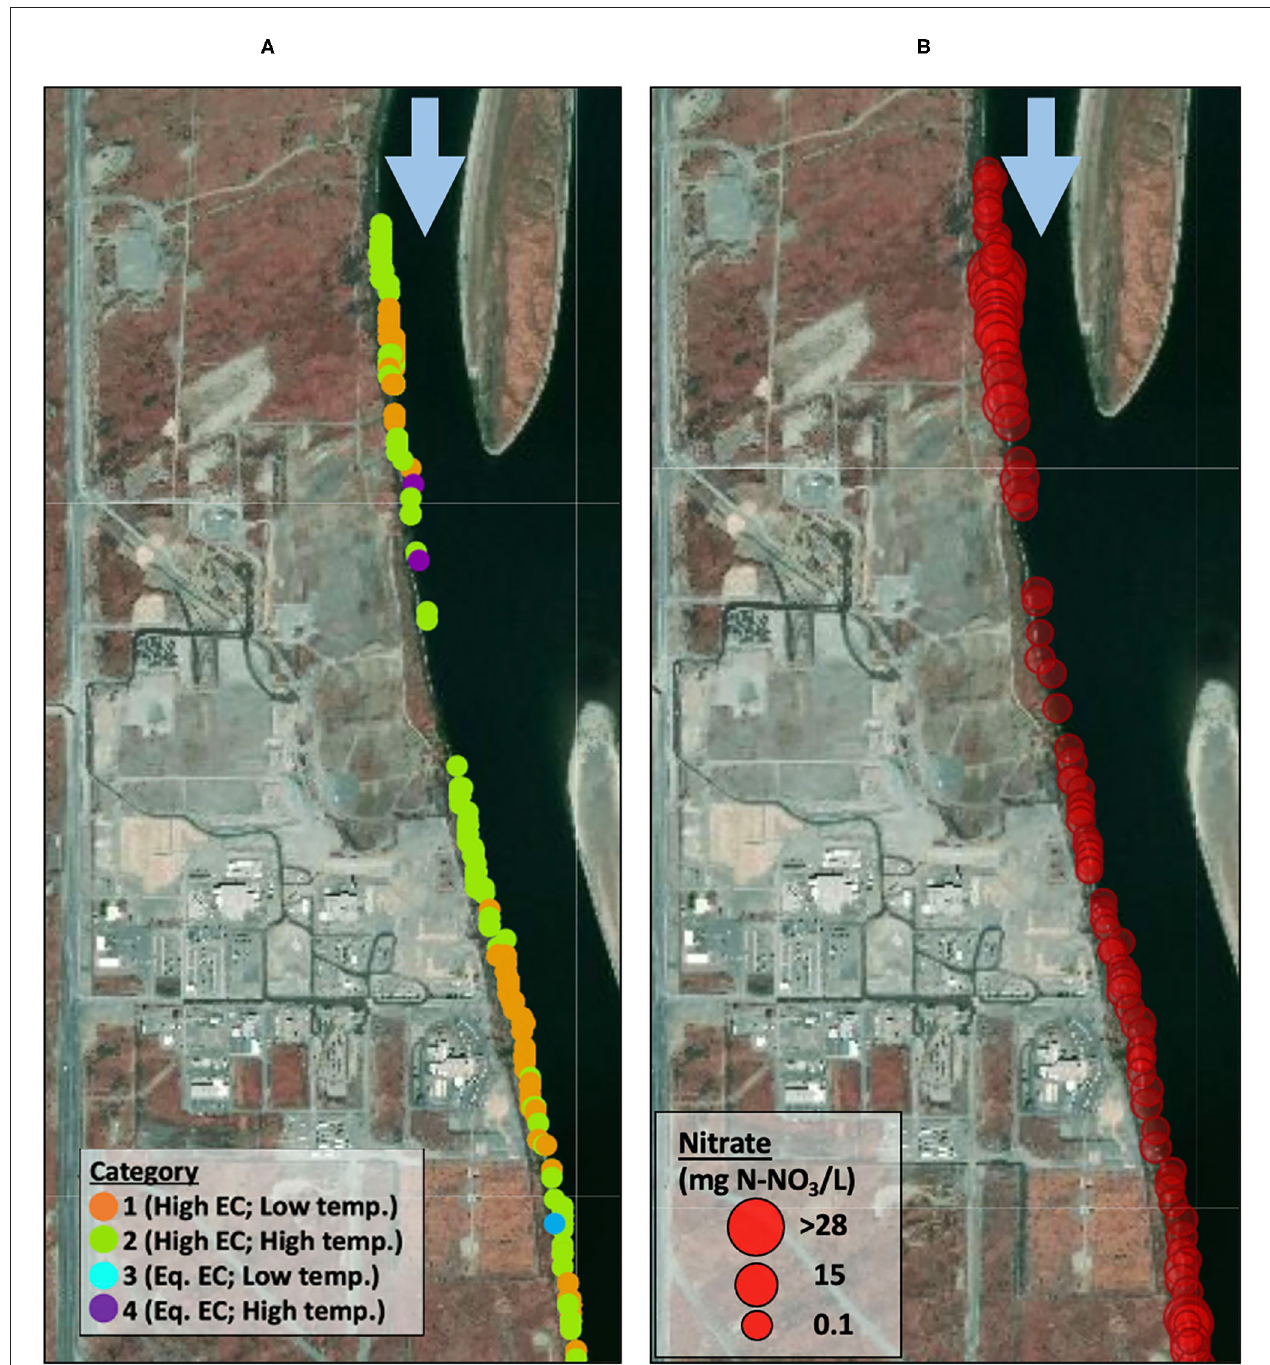
east (USDOE, 2010). This groundwater plume is located in the same area as a cluster of nitrate anomalies along the shoreline, and so it is reasonable to assume this is the source of the nitrate observations clustered along the 300-Area shoreline. The other location of nitrate anomalies on the western shoreline is